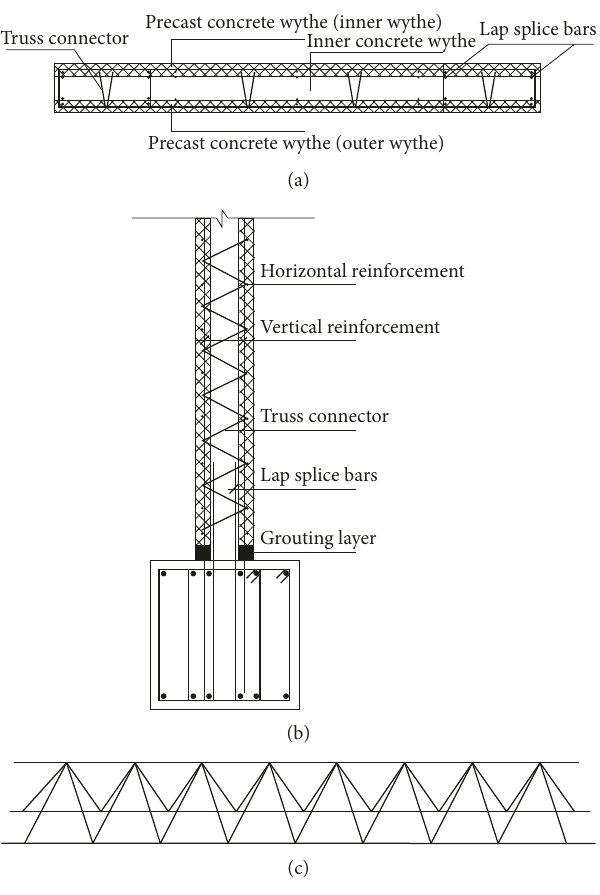
Figure 1: Configuration of the superposed shear wall: (a) cross section forms; (b) lap splice bars across horizontal joints; (c) truss connector.